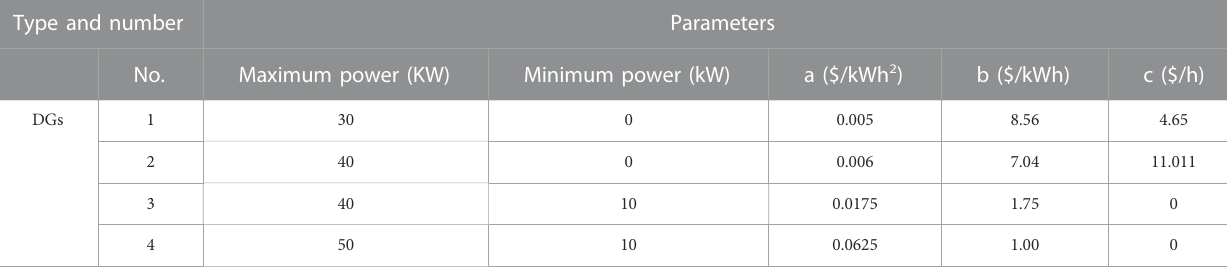
TABLE 2 Operation parameters of the components in the MG system. Type and